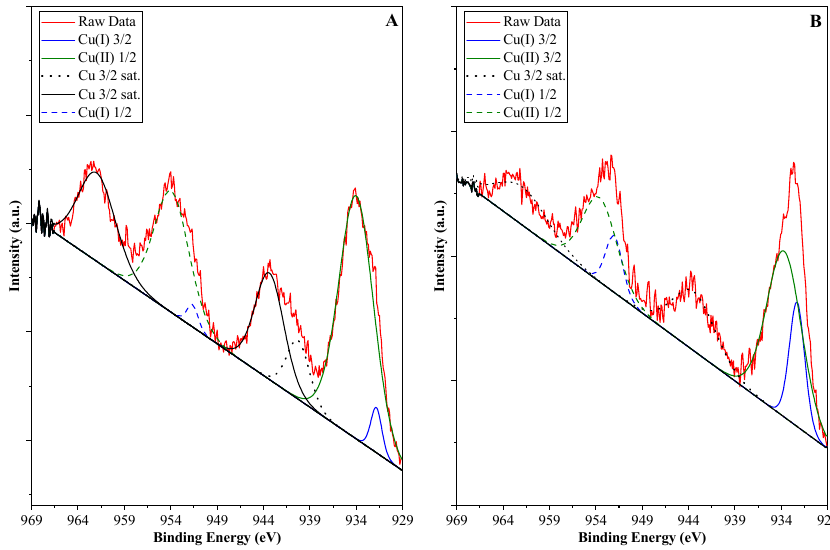
Figure 12. The Cu2p X-ray photoelectron spectroscopy (XPS) spectra of two copper containing composites, ( A )—AA-5Cu and ( B )—P25-5Cu, showing the presence of Cu(I) and Cu(II).